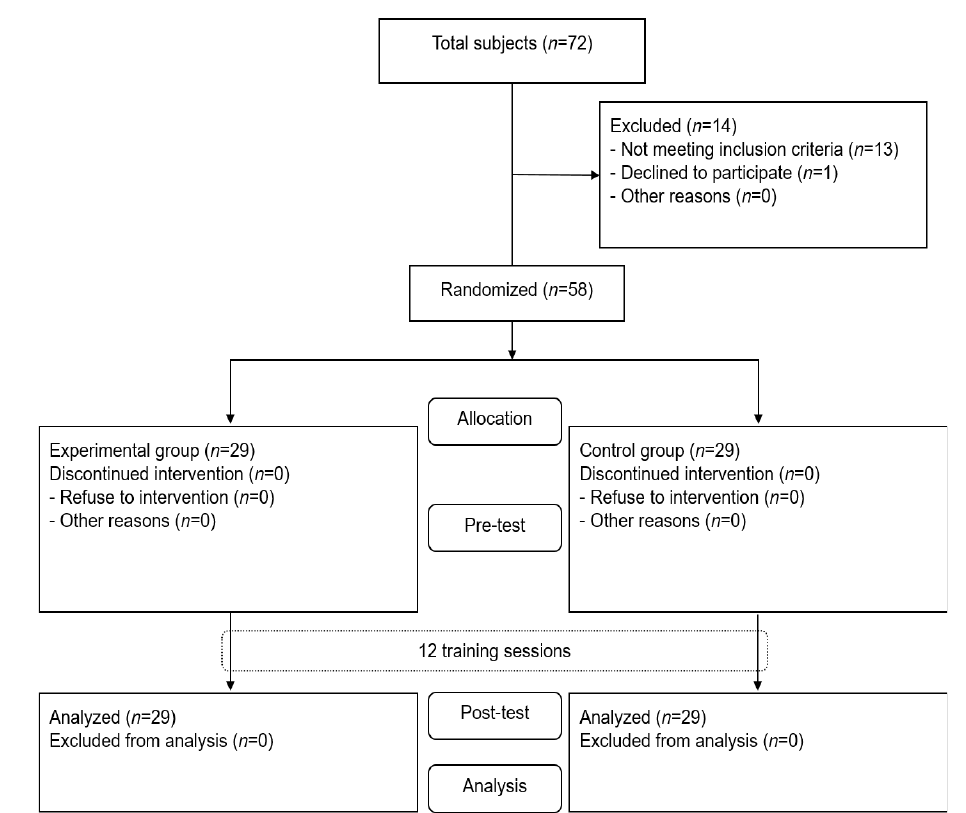
Figure 1. Flow diagram of subjects in the study.